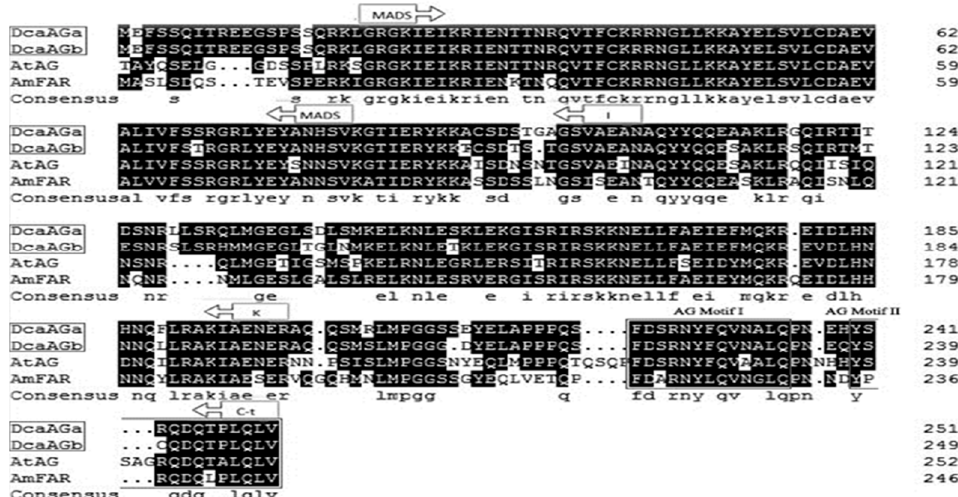
Figure 2. Protein sequence comparison of DcaAGa, DcaAGb, and the AG-related MADS domain proteins in Arabidopsis thaliana and Antirrhinum majus . The MADS domain, K domain, and I domain are marked with an arrow box. The AG motifs I and II in the C terminal region are boxed, highly conserved for AG-like protein.